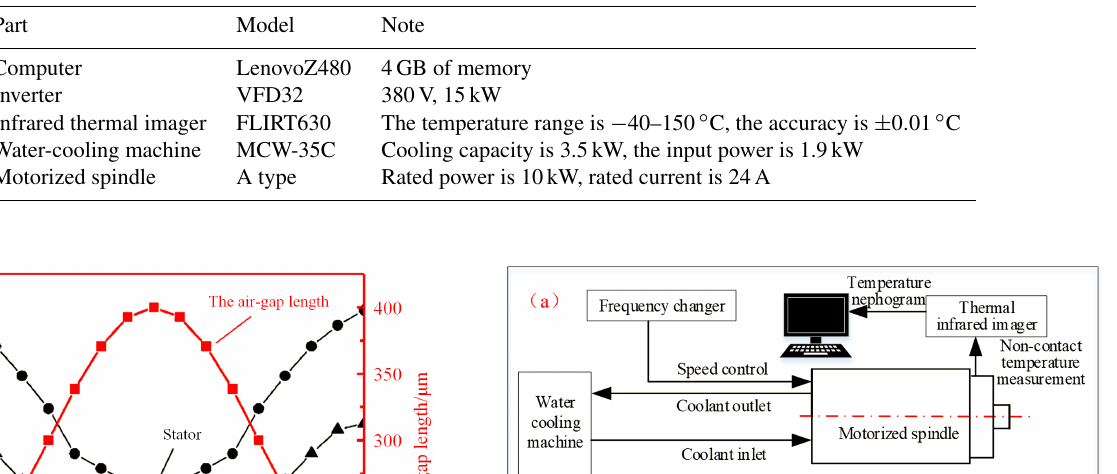
Table 4. Non-contact temperature test bed equipment parameters.